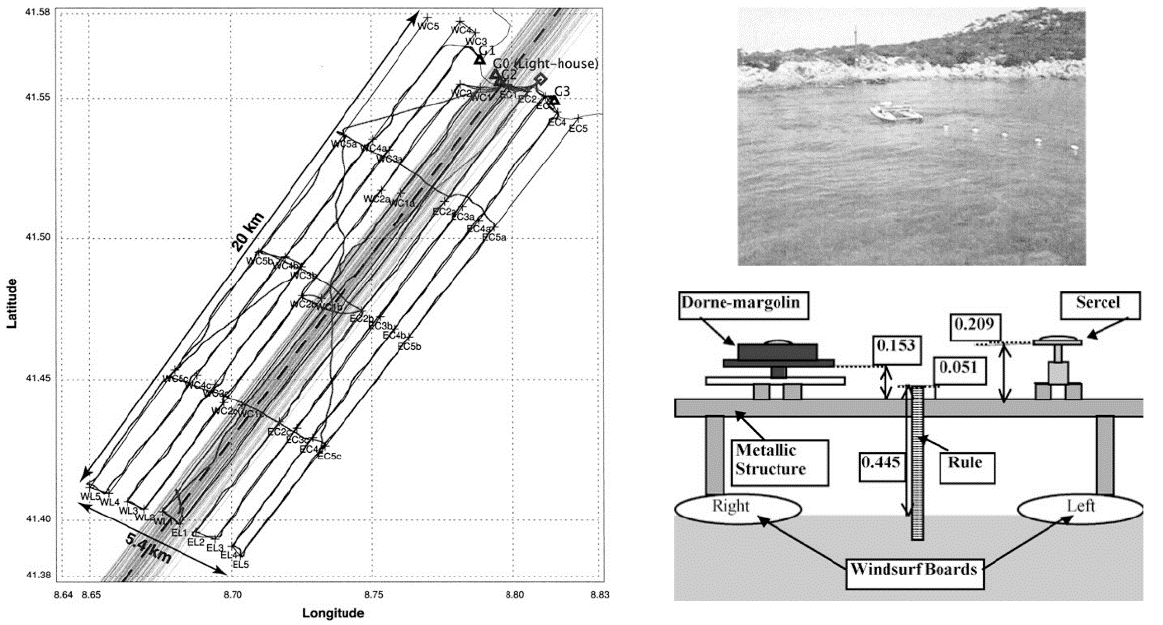
Figure 3. (Left) GPS data collected during 1999 experiments, (Right) photo and scheme of the GPS-Catamaran facility [3].